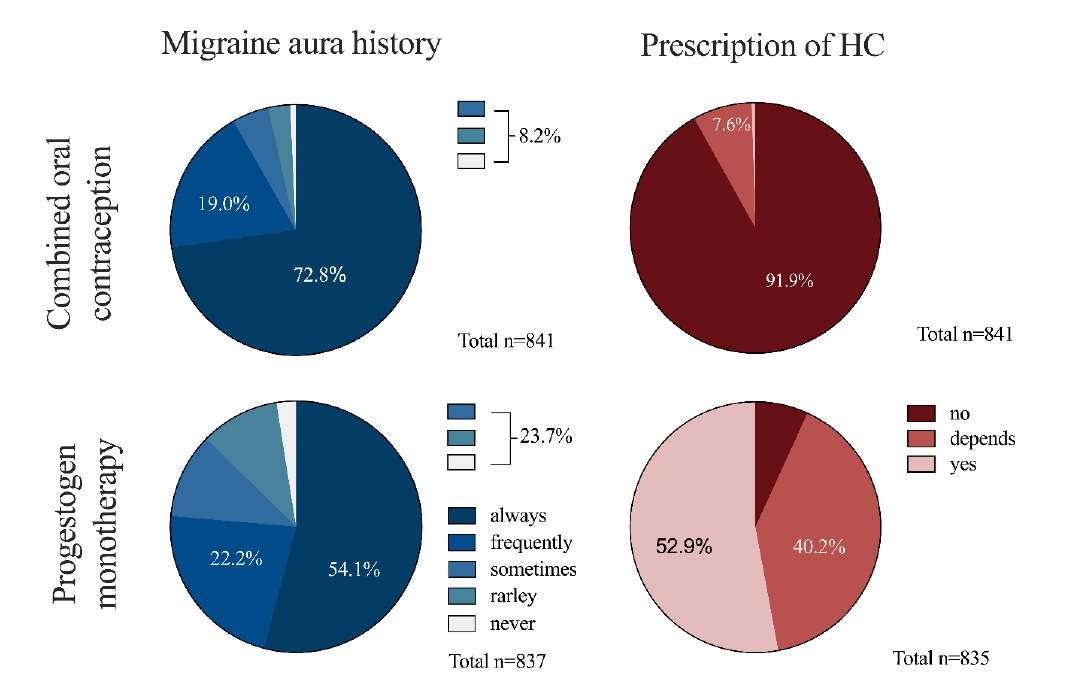
Figure 3. Hormonal contraception and migraine aura. The figure shows the absolute frequencies of asking about migraine aura before initiating treatment with COC or PM, as well as prescribing pat- terns of COC and PM in the case of concomitant migraine aura. Table 3. Factors limiting HC prescription in concomitant migraine with